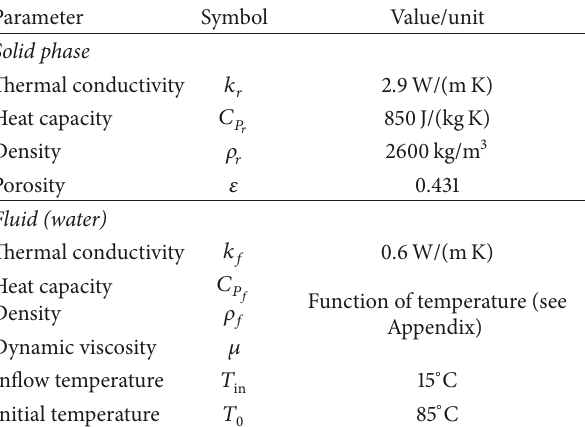
Table 1: Parameters used in the